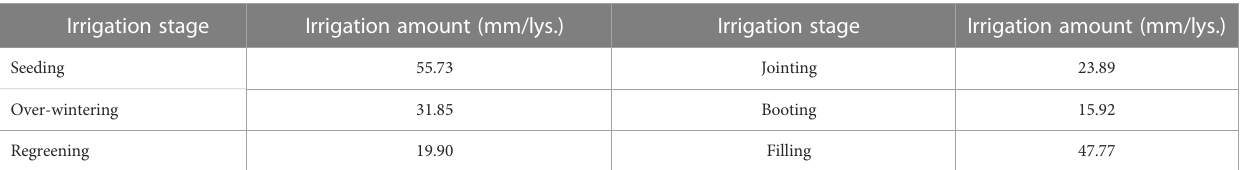
TABLE 2 Irrigation period and irrigation amount of winter wheat.